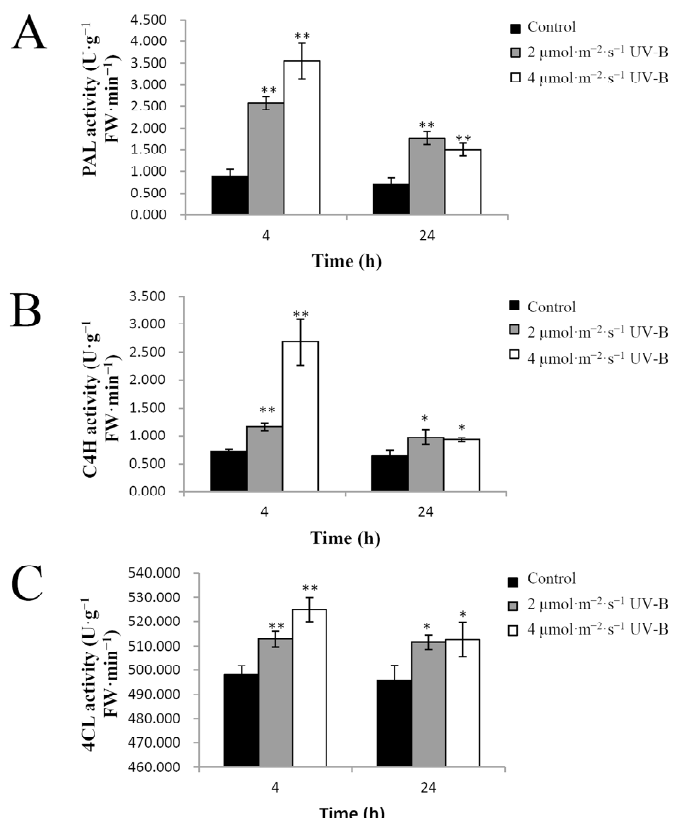
Figure 6. The effect of UV-B radiation on the activities of flavonoid biosynthesis enzymes in pakchoi. ( A ) The activity of PAL in 25-day-old seedlings treated with either 2 µmol·m − 2 ·s − 1 or 4 µmol·m − 2 ·s − 1 of UV-B radiation at 4 h or 24 h. ( B ) The activity of C4H in 25-day-old seedlings treated with either 2 µmol·m − 2 ·s − 1 or 4 µmol·m − 2 ·s − 1 of UV-B radiation at 4 h or 24 h. ( C ) The activity of 4CL in 25-day-old seedlings treated with either 2 µmol·m − 2 ·s − 1 or 4 µmol·m − 2 ·s − 1 of UV-B radiation at 4 h or 24 h. The plants without UV-B radiation served as controls. Three independent biological replicate experiments were performed; data points represent the mean ± SE of three biological replicates. Asterisks indicate a significant difference (* p < 0.05; ** p < 0.01) relative to the corresponding control, using Student’s t